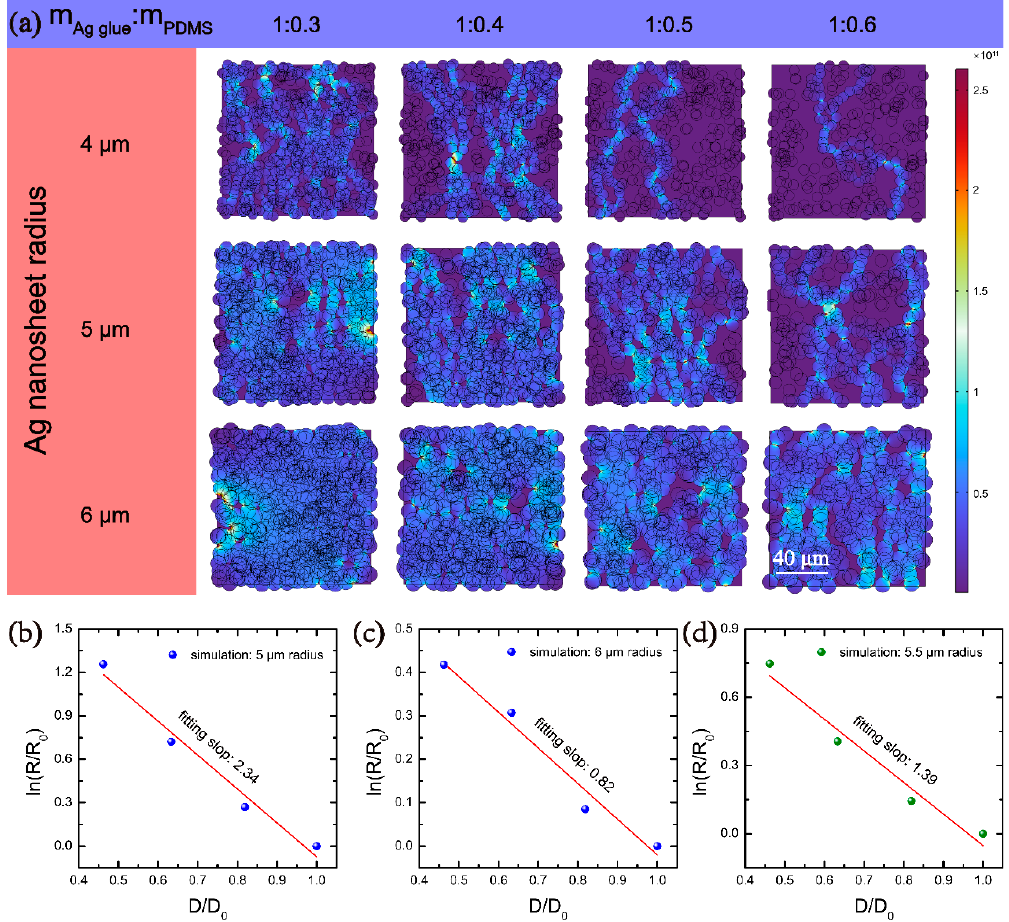
Figure 9. Simulation of the conductivity of electrodes with different Ag nanosheet radii. ( a ) Com- parison of the current density distribution when the radius of Ag nanosheets is 4, 5, and 6 μ m, respectively. Contact point theoretical fitting for the Ag nanosheet radius of ( b ) 5 μ m, ( c ) 6 μ m, and ( d ) 5.5 μ m, respectively.